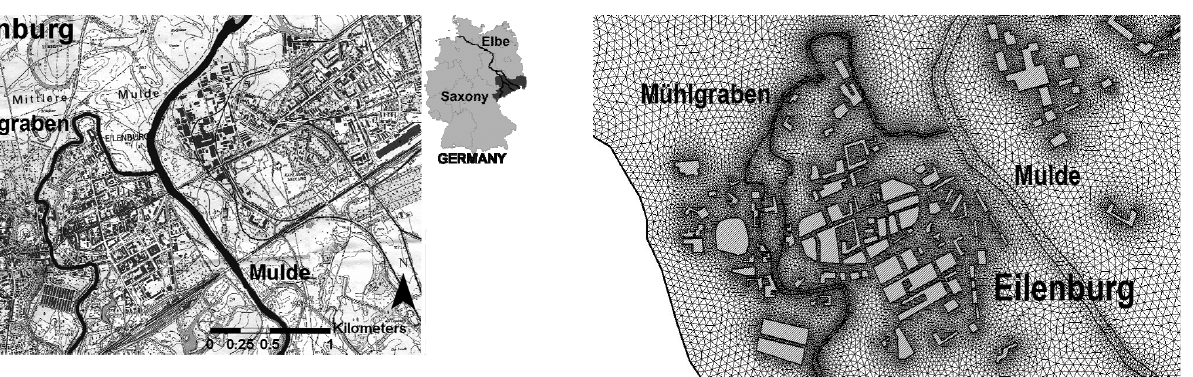
Fig. 2. Layout of the mesh of the simplified 2-D-finite element Figure 2. Layout of the mesh of the simplified 2D-finite element model.